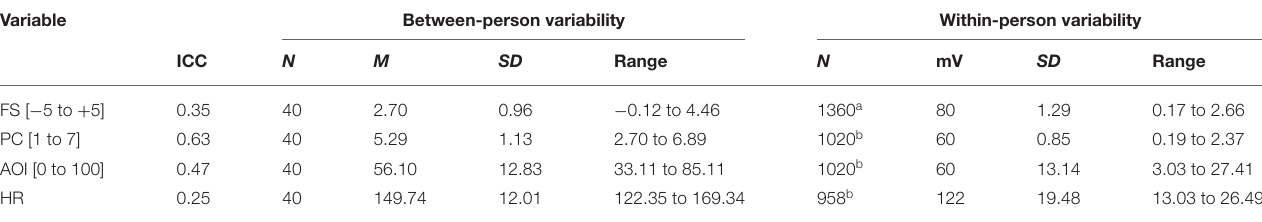
TABLE 2 | Descriptive statistics for study variables. Variable